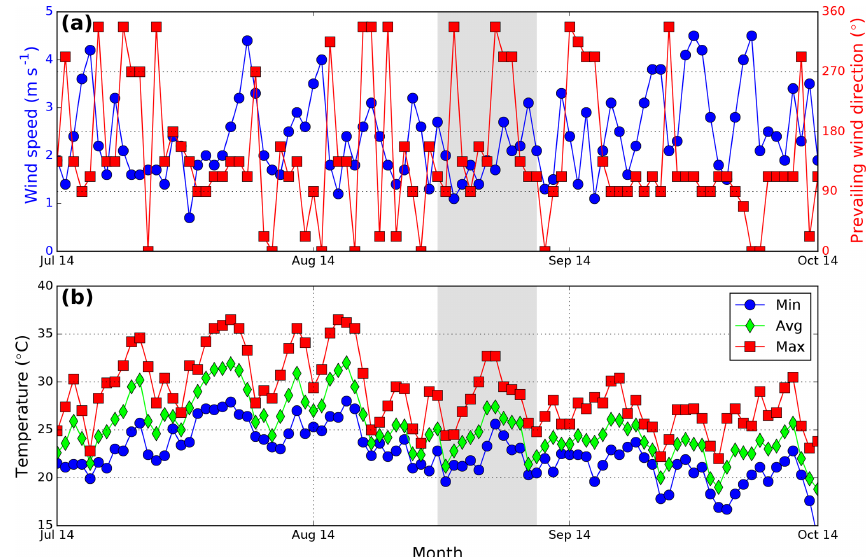
Figure 12. (a) Time series of wind speed (blue curve) and wind direction (red curve). (b) Time series of daily minimum (blue curve), daily average (green curve) and daily maximum temperatures. The gray shadowed area indicates the Youth Olympic Games period (16 to 28 August 2014).